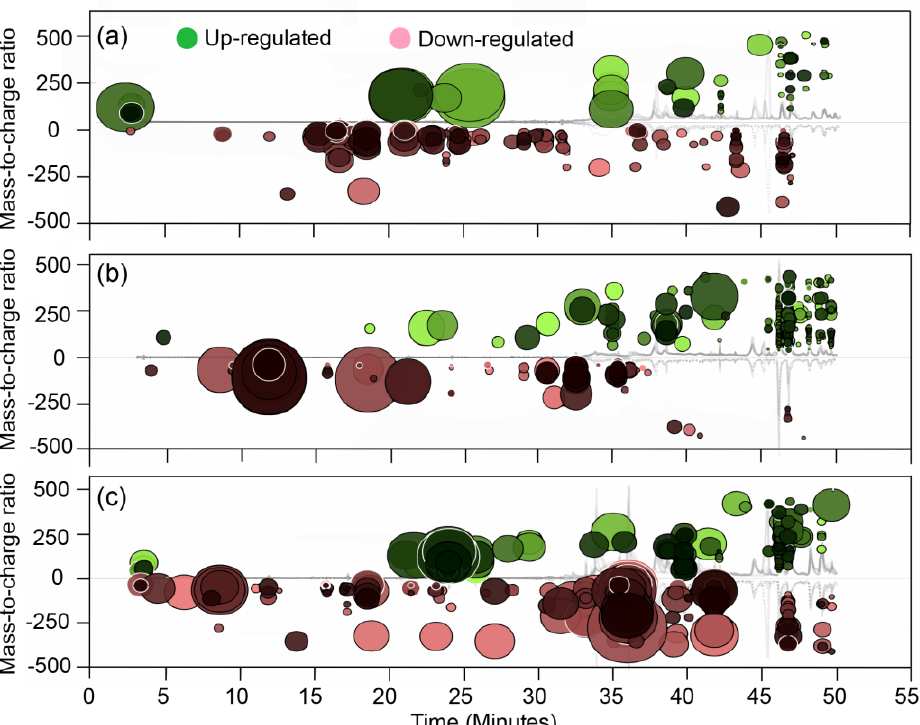
Figure 1. XCMS Cloud plot representation of the significant characteristic features (metabolites) between ( a ) cow manure and digestate, ( b ) swine manure and digestate, ( c ) chicken manure and digestate. Green colored spots correspond to features generated from up-regulated metabolites indicating the metabolite features whose intensity increased after AD. Red-colored spots represent the features generated from down-regulated metabolites indicating the metabolite features whose intensity decreased after AD. The size of each circle represents the fold change of feature changes. The p-values are represented by the color intensity of the metabolite feature, where the features with high p-values are darker compared to the features with low p -values. The ‘y’ coordinate of each feature corresponds to the mass-to-charge ratio of the compound.